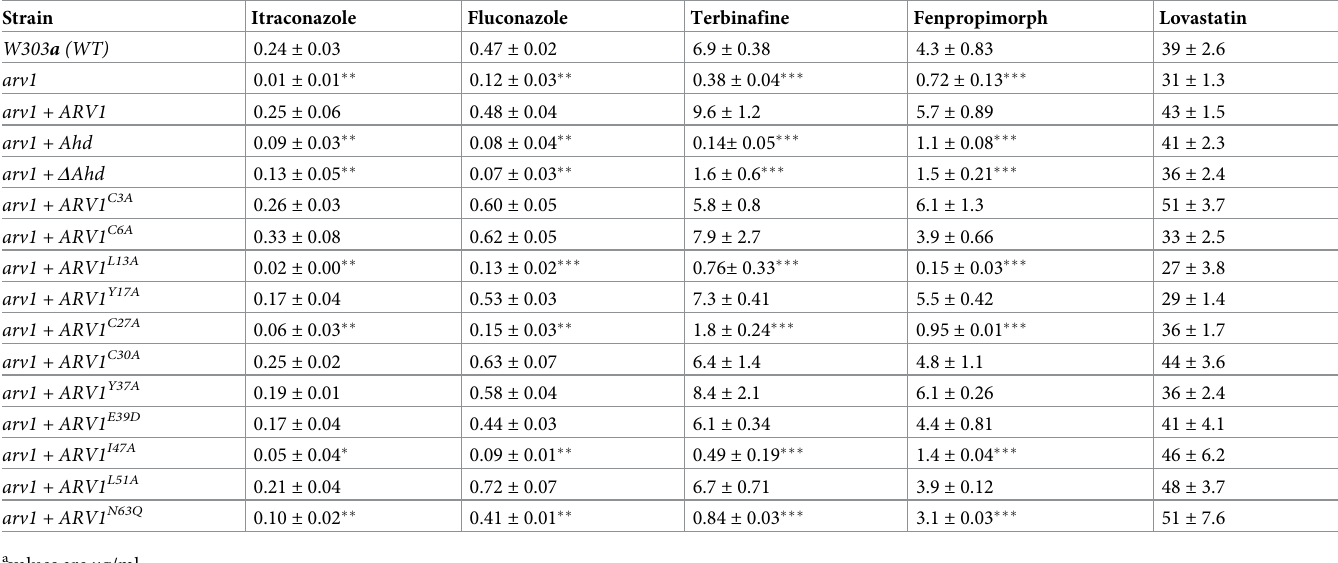
Table 1. Antifungal susceptibilities of Scarv1 site-directed mutant strains.